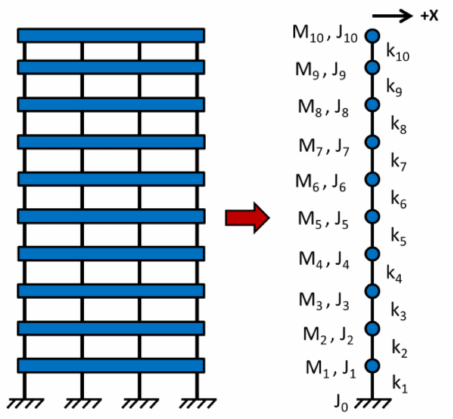
Figure 5. MODF system used in the